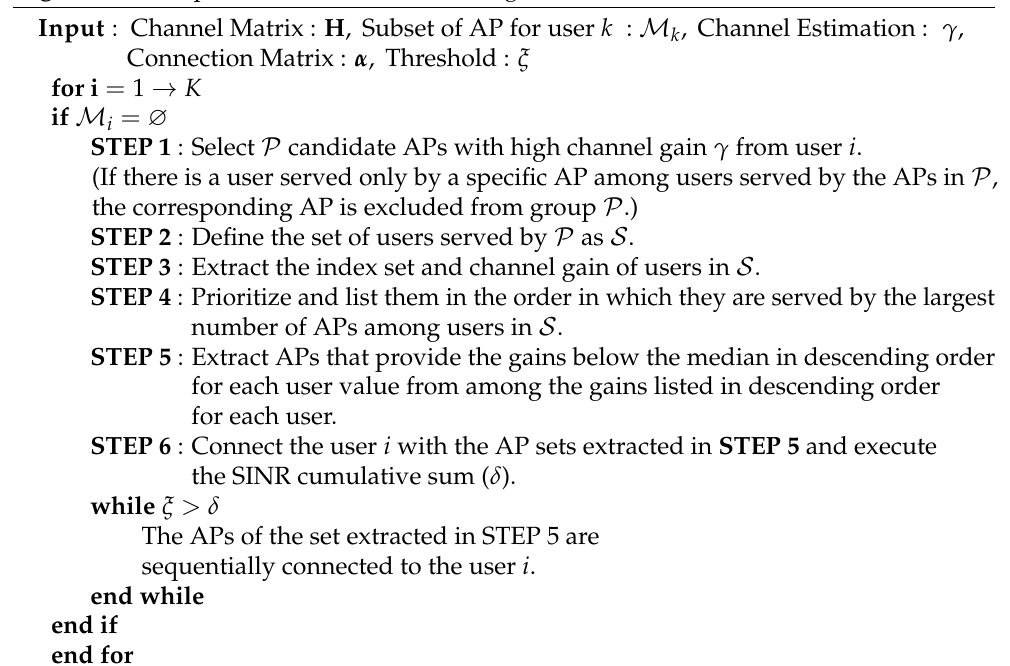
Algorithm 1 Proposed Unserved user Serving